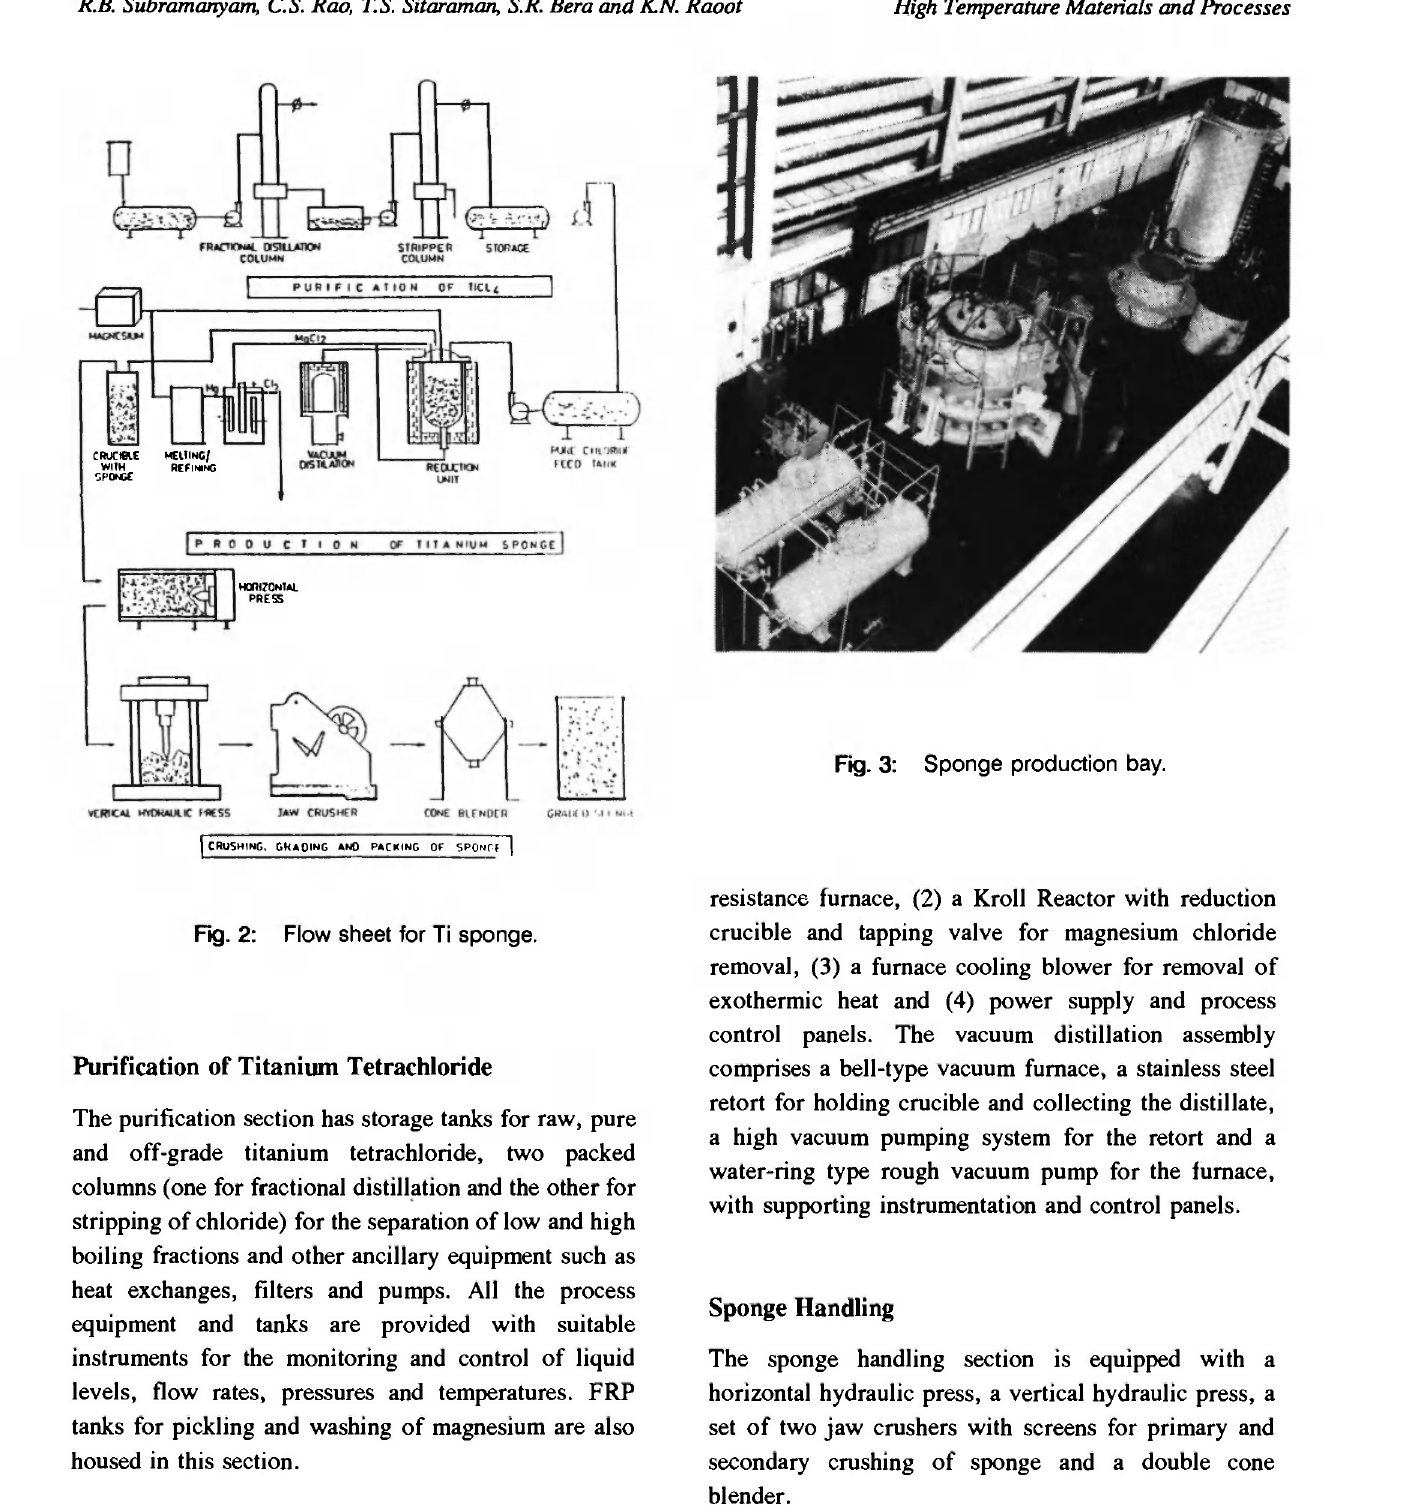
Fig. 2: Flow sheet for Ti